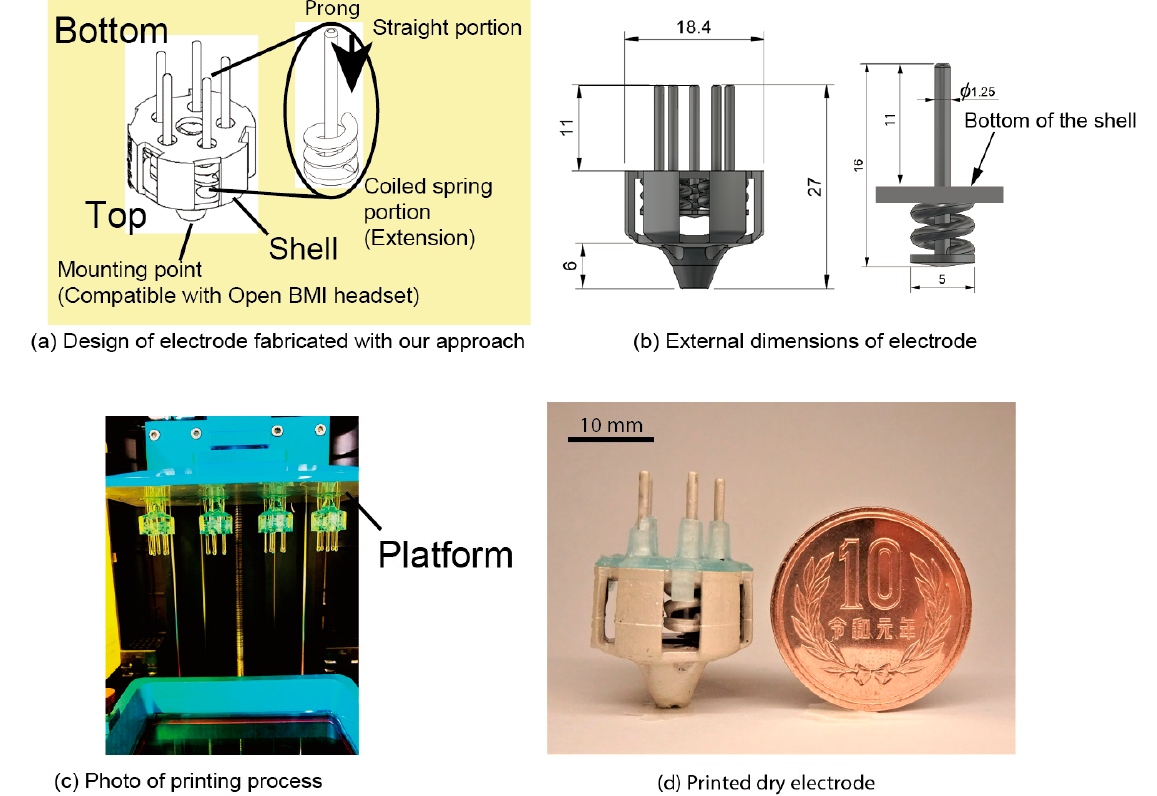
Figure 3. The 3D printed electrode ( a ) Design of electrode with coiled-spring prongs. ( b ) External dimensions of electrode. ( c ) Photograph of stereolithography (SLA) 3D printing process. ( d ) Electrode after being coated with conductive paste.